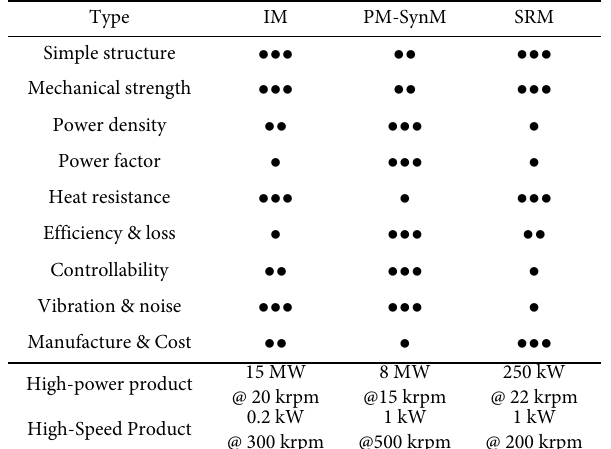
Table 5 Main feature and notable products of three kinds of HS-EM Type